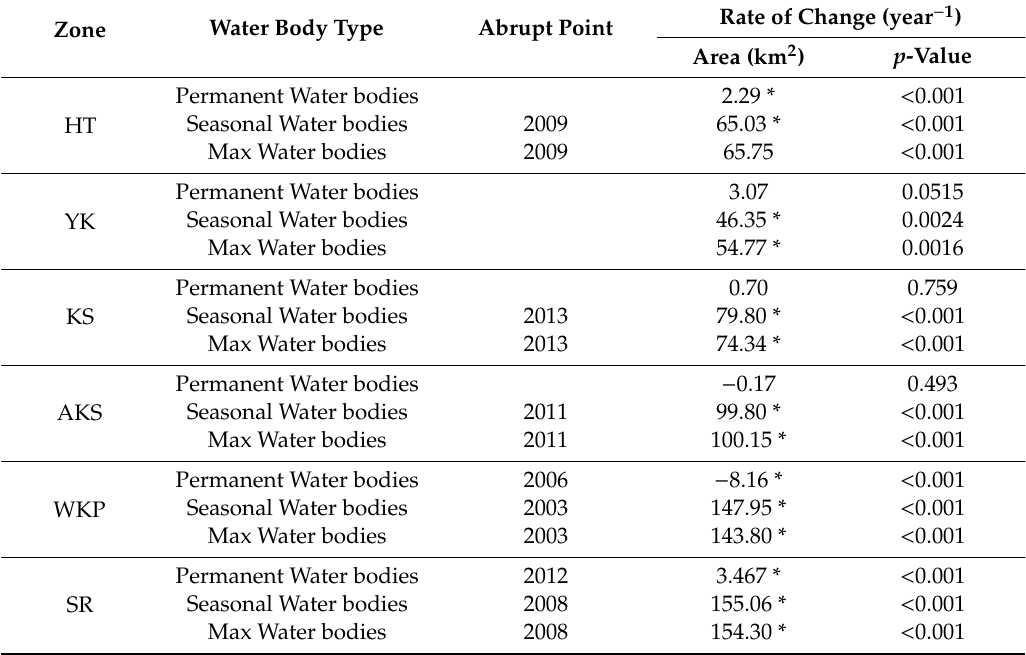
Figure 10. The annual variation of open-surface water bodies for 1992 to 2019 in the ( a ) HT; ( b ) YK; ( c ) KS; ( d ) AKS; ( e ) WKP; ( f ) SR; ( g ) TMS; ( h ) TD; and ( i ) KD. HT, Hotan River Basin; YK, the Yarkant River Basin; KS, Kashgar River Basin; AKS, Aksu River Basin; WKP, Weikan-Kaidu-Peacock River Basin; SR, Rivers in Southern Xinjiang; TMS, the Tarim Main Stream; TD, Taklamakan Desert; and KD, Kumtag Desert. Table 3. Statistical summary of surface water bodies area dynamics in TRB’s nine zones. HT, Hotan River Basin; YK, the Yarkant River Basin; KS, Kashgar River Basin; AKS, Aksu River Basin; WKP, Weikan-Kaidu-Peacock River Basin; SR, Rivers in Southern Xinjiang; TMS, the Tarim Main Stream; TD, Taklamakan Desert; and KD, Kumtag Desert.